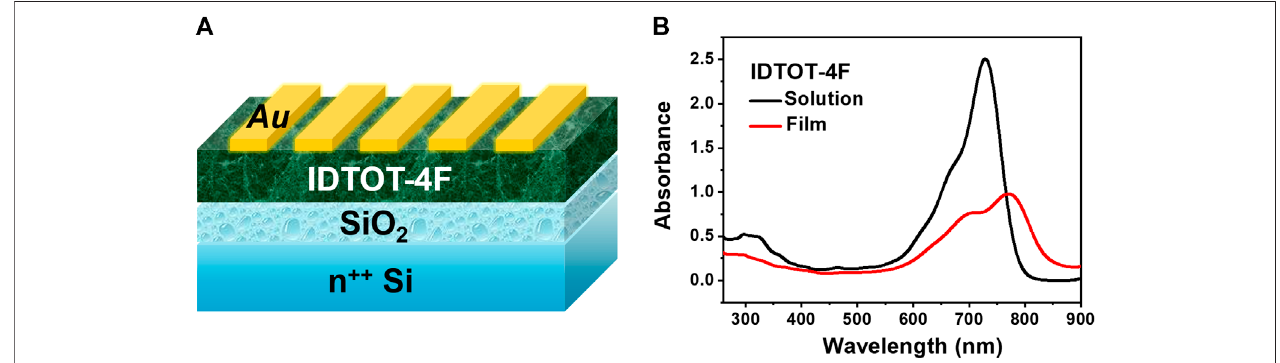
FIGURE 1 | (A) The structure of IDTOT-4F based optoelectrical devices; (B) The UV-vis absorption spectrum of IDTOT-4F in chloroform solution (concentration: 1.0 × 10 – 5 mol/L) and as thin fi